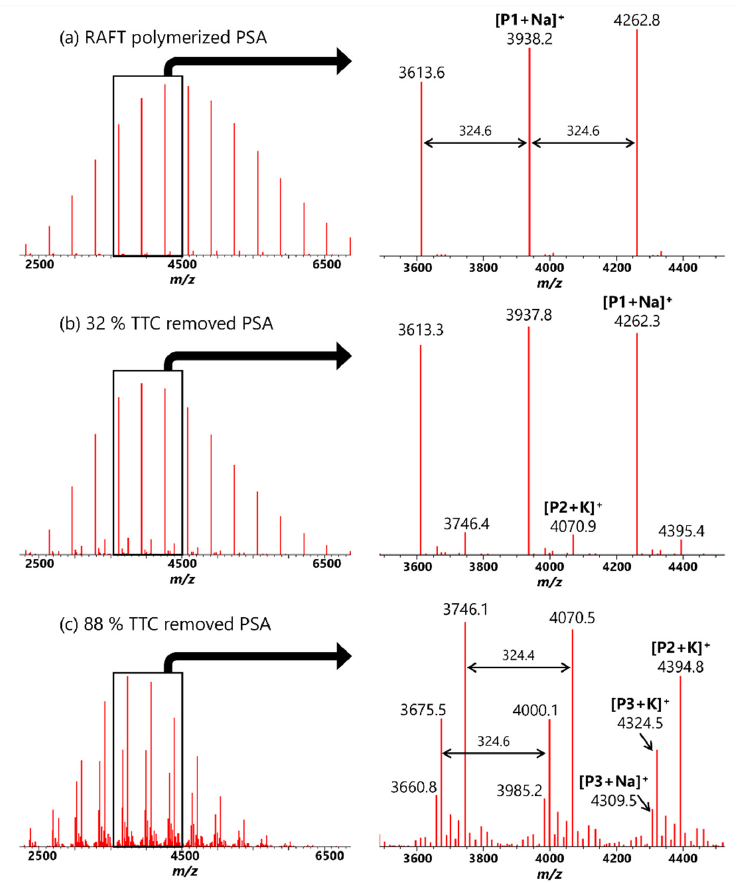
Figure 4. MALDI-TOF MS spectra for ( a ) RAFT polymerized PSA (PSA4.9k in Table 1), ( b ) 32% TTC